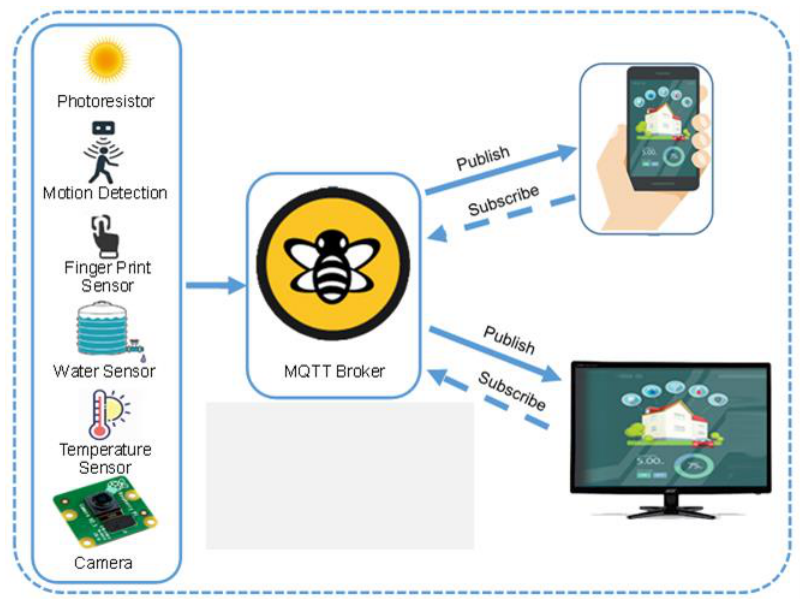
Figure 3. Conceptual representation of Broker layer, where MQTT broker is used to transmitting sensor data to the end-user on their smartphones or PCs.